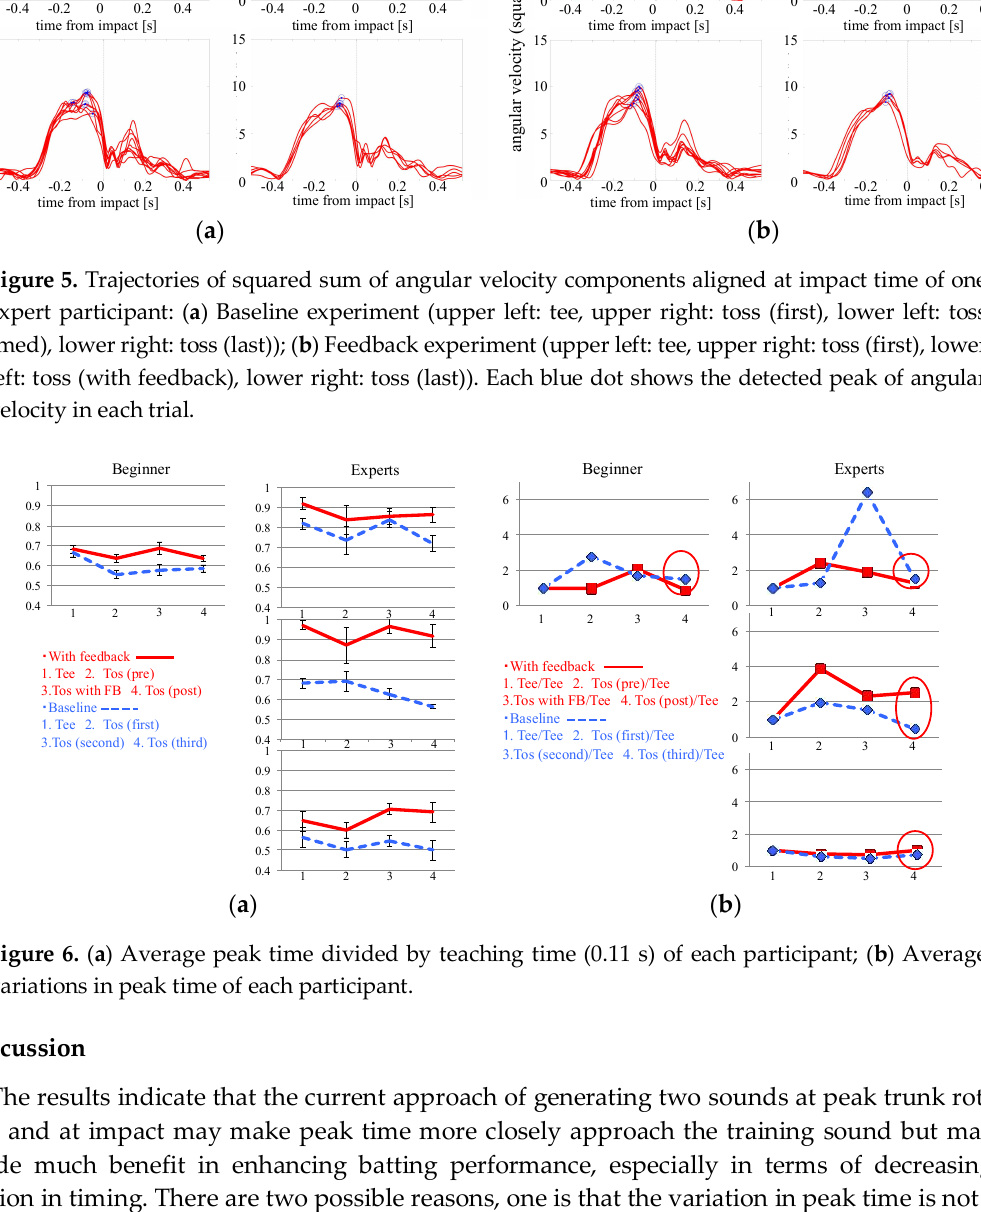
Figure 6. ( a ) Average peak time divided by teaching time (0.11 s) of each participant; ( b ) Average variations in peak time of each participant.